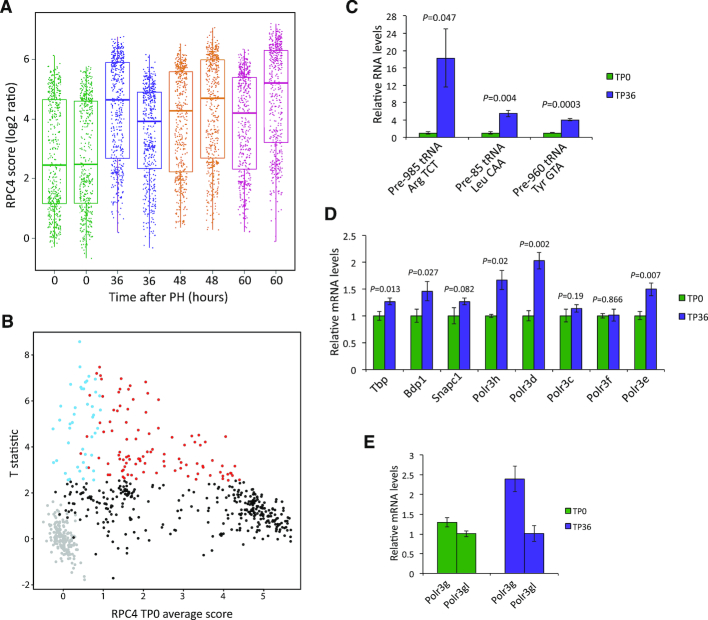
(A) Distribution of RPC4 scores for Pol III genes across time and replicates. Dots represent Pol III genes, and their distribution is summarized with their median (thicker horizontal bar), lower/upper quartile (box) and ±1.5 times the interquartile range (end of whiskers). Genes with an RPC4 occupancy score below the cutoff in all time points and replicates are not shown. (B) Plot of T statistics estimated for the TP0 to TP36 transition as a function of the average RPC4 score across replicates at TP0. A positive value of the T statistic indicates a score increase from TP0 to TP36. Red and blue dots, loci with an associated FDR<0.05, with blue dots indicating loci with an RPC4 score below cutoff at TP0. Black dots, loci with an associated FDR >0.05. Gray dots, loci with scores below the cutoff at both TP0 and TP36. (C) RT-qPCR quantification (normalized to Actb mRNA level) of indicated precursor tRNAs, relative to the values at TP0. Error bars represent ± SD. n = 3. The P-values were calculated using Student's t-test. (D) RT-qPCR quantification (normalized to Actb mRNA level) of the indicated mRNAs, relative to the values at TP0. Error bars and P-values as in C. (E) RT-qPCR quantification of Polr3g relative to Polr3gl mRNA. Error bars as in C.